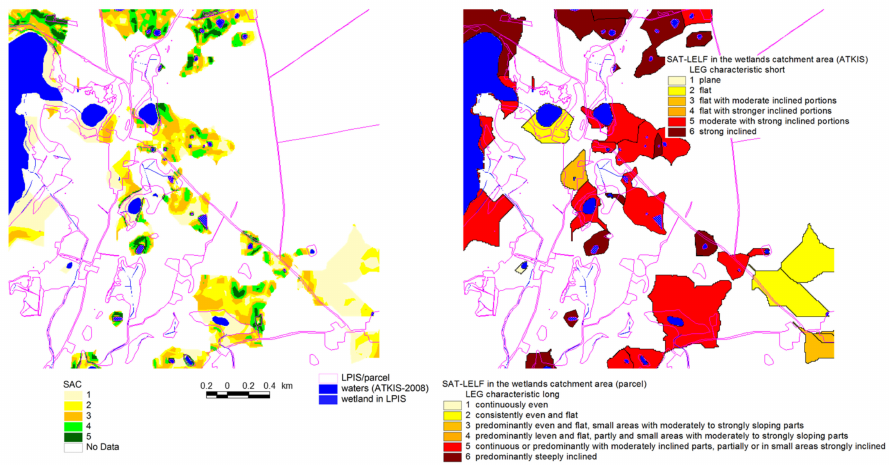
Figure 6. Slope angle classes (SAC) and slope association types (SAT) in the catchments of water bodies inside field blocks, based on the work of [28], same color scheme as in Table